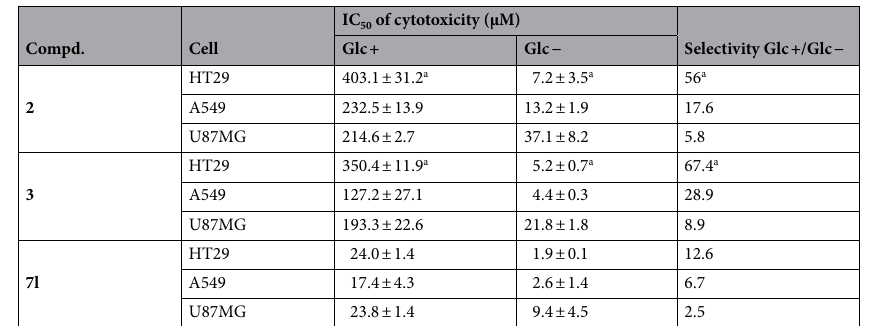
Table 2. Cytotoxicity of 2 , 3 and 7l on HT29, A549 and U87MG cells. IC 50 (mean ± SD, n = 3) was determined by MTT assay on each cell following 48 h of drug treatment in the presence (Glc +) or absence (Glc −) of glucose. a Data from ref. 24 . Concentration response curves for biguanide 2 , 3 and 7l on A549 and U87MG and 7l on HT29, A549 and U87MG can be found in Figures S3, S4 and S5.